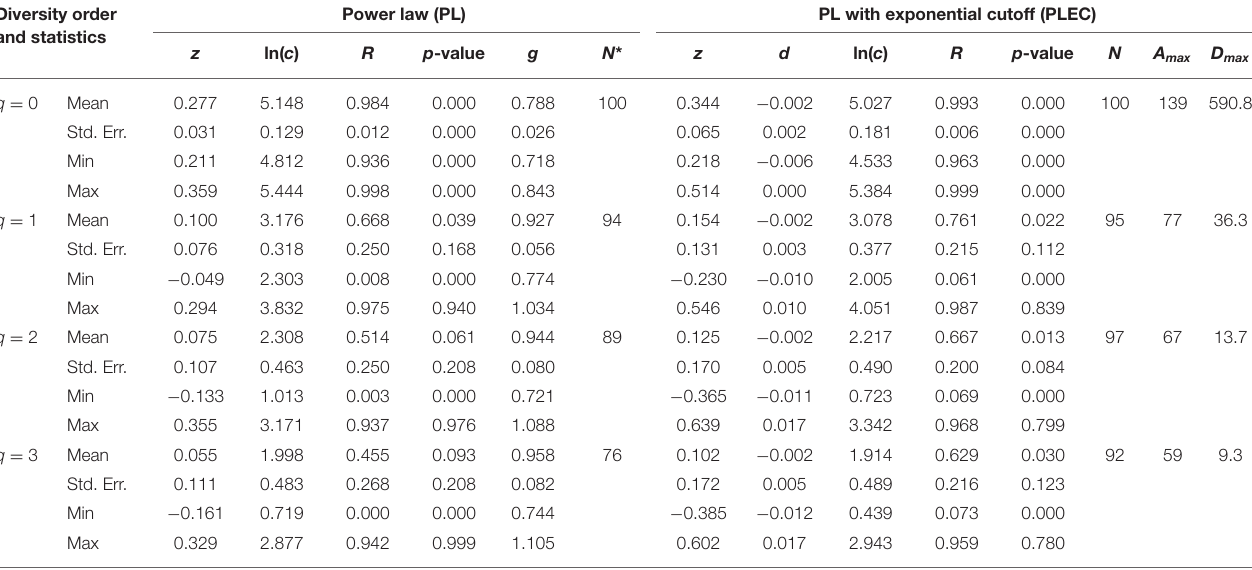
TABLE 1 | The parameters of alpha -DAR ( alpha -diversity-area relationship) computed with 100 times of re-sampling at genus level for the human semen microbiome. Diversity order Power law (PL) PL with exponential cutoff (PLEC) and statistics